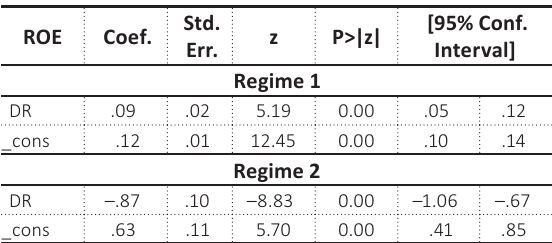
Table 3. The threshold model with one